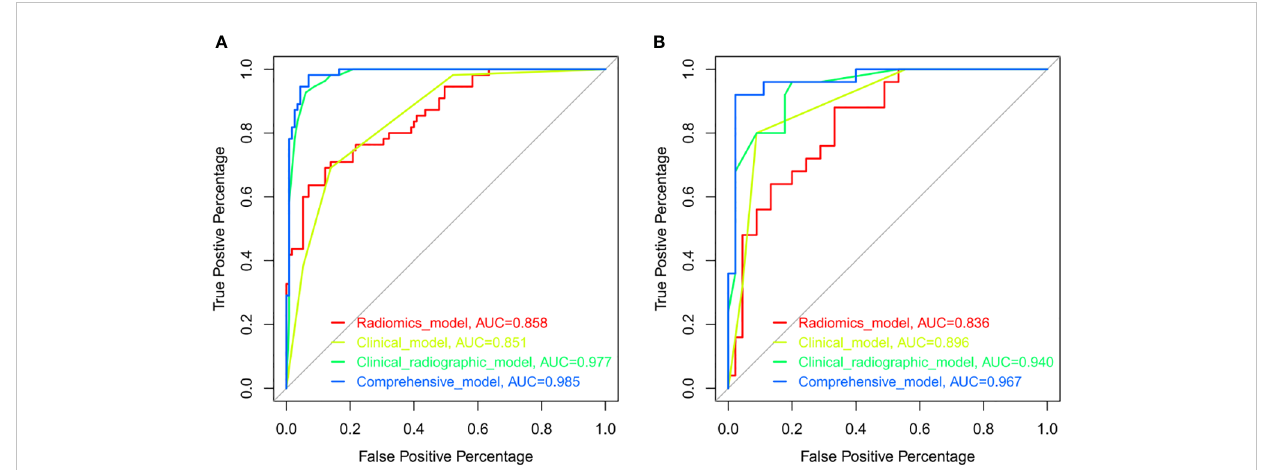
FIGURE 4 ROCs of the radiomics model (red), clinical model (yellow), clinical-radiographic model (green), and comprehensive model (blue) in the training (A) and validation (B) sets. ROC indicated the differential diagnostic ef fi cacy of each model. The more accurate the diagnostic model, the more the ROC shifts toward the Y-axis, with the AUC approaching a value of